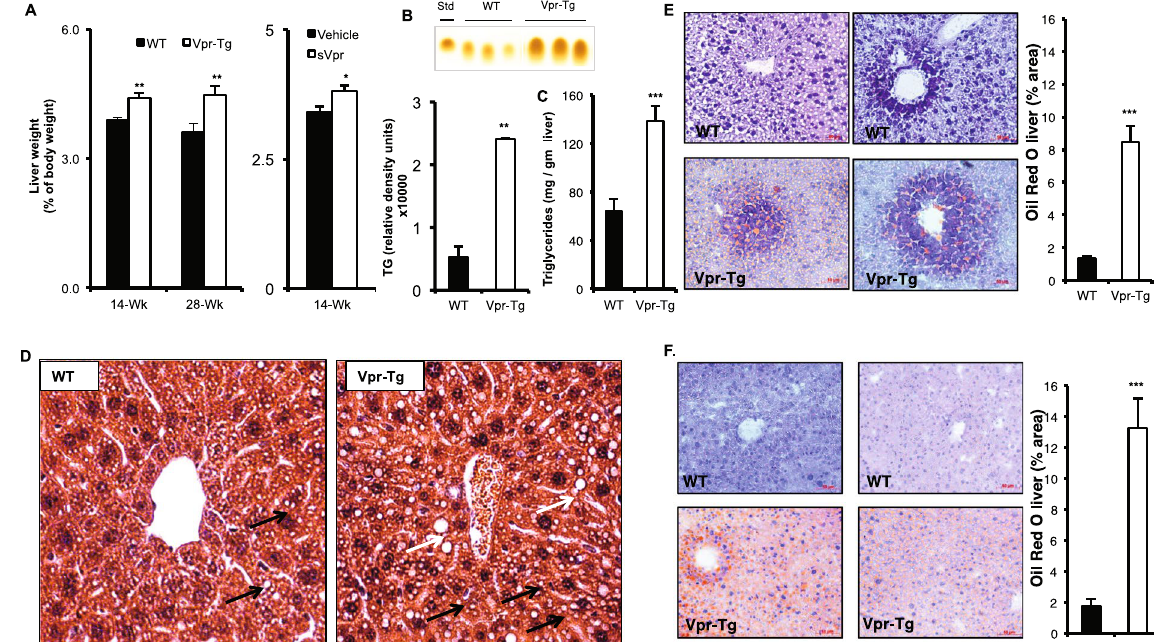
Figure 1. Vpr transgenic mice develop hepatosteatosis. ( A ) Increased liver mass (normalized to body weight) was present in Vpr-Tg compared to WT mice of 14 week old mice (n = 5–6 per group) and 28 week old mice (n = 4–5 per group) and sVpr- compared to vehicle-treated mice (n = 7 per group). ( B ) Increased liver triglyceride content was present in Vpr-Tg mice by TLC (n = 3 per group) and ( C ) by colorimetric assay (n = 5–6 per group). ( D ) Steatosis was observed in Vpr-Tg liver (hematoxylin-eosin stain). Left panel shows liver parenchyma around a centrilobular vein in WT mouse, with a pattern of microsteatosis (black arrows). Right panel shows peri-centrilobular area of liver in Vpr-Tg mouse, with both microsteatosis (black arrows) and macrosteatosis (white arrows). Scale bar = 50 μ m. ( E ) Oil Red O–stained liver sections of 14-week Vpr-Tg show increased lipid accumulation compared to WT mice. Bar graph shows quantification of ORO-stained area. ( F ) Oil Red O–stained liver sections of 28-week Vpr-Tg show progressive lipid accumulation compared to WT mice. Bar graph shows quantification of ORO-stained area. Values are mean ± SE. * P < 0.05, ** P < 0.01, *** P <